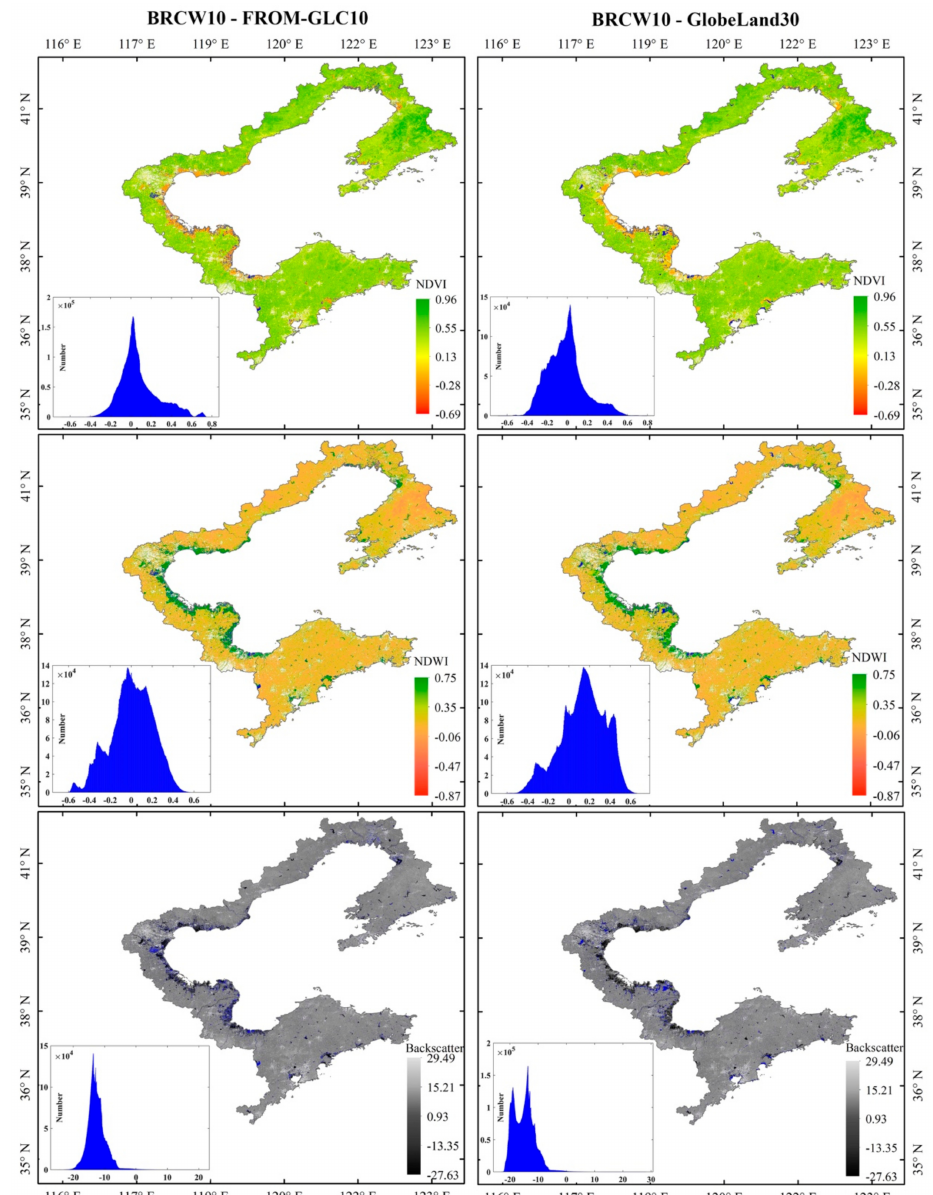
Figure 9. Spatial and frequency distributions of the normalized di ff erence vegetation index (NDVI), normalized di ff erence water index (NDWI), and vertical–vertical polarization (VV) pixels that were wetland in the BRCW10 wetland map but not in the FROM-GLC10 (left column) and in the GlobLand30 (right column) derived wetland